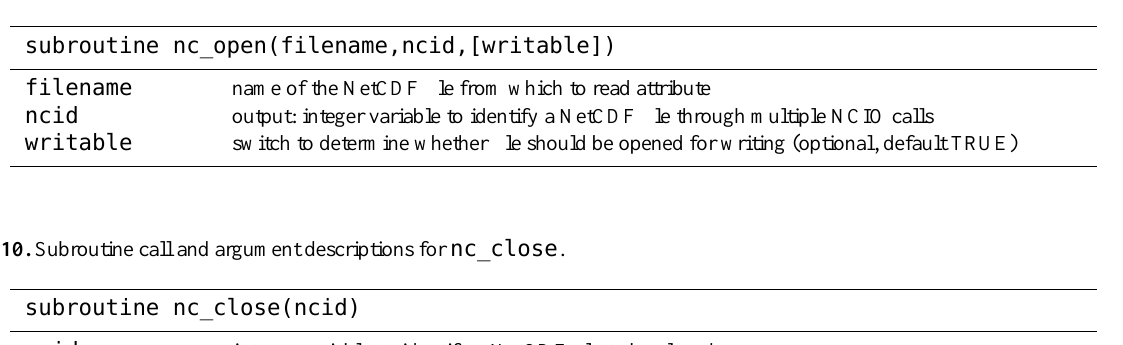
Table A9. Subroutine call and argument descriptions for nc_open .